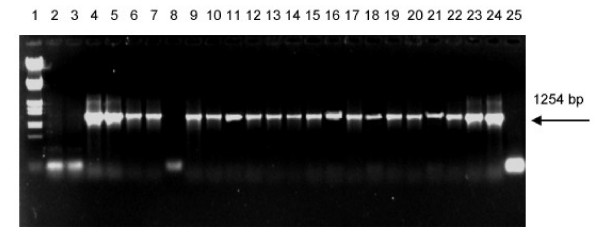
PCR of clinical isolates of M. tuberculosis for moaA3 gene. Lane 1: Marker- λ DNA double digest (EcoR I/Hind III), lane 2: H37Rv, lane 3: H37Ra, lane 4: M. bovis BCG, lanes 5–24: Clinical isolates RGTB 29, 37, 40, 43, 55, 60, 70, 86, 87, 93, 95, 109, 110, 123, 142, 144, 154, 167, 177, 193 respectively, lane 25: Negative Control.